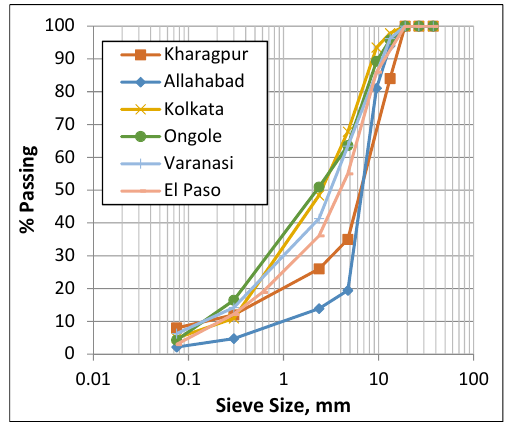
Figure 1. Gradations of RAP aggregates used in the present study.